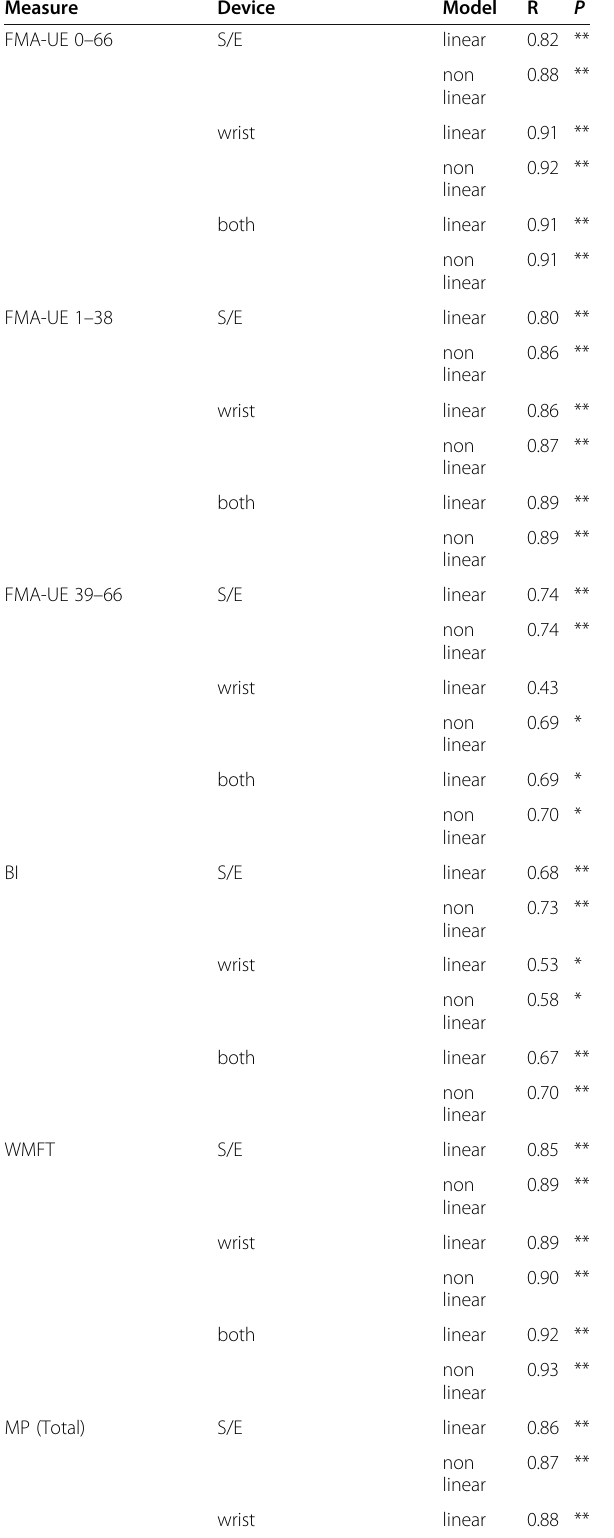
Table 3 Correlation of kinematic and kinetic metrics with clinical measures Measure Device Model